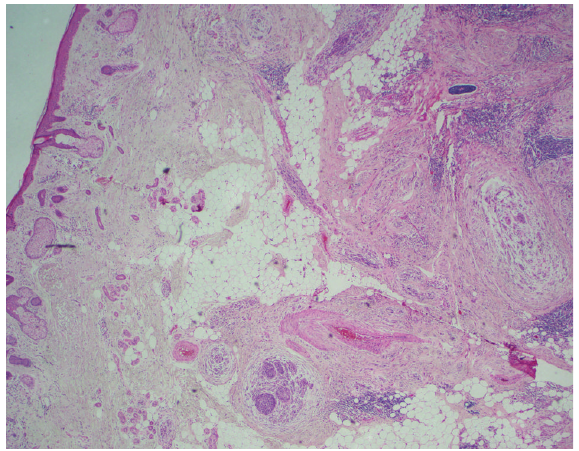
Figure 2: Low power ( × 20) view of skin with epidermis on the left and subcutis on the right. At this magnification we can identify nodules within the subcutis: at the centre, at the bottom, centre top, and on the right in the